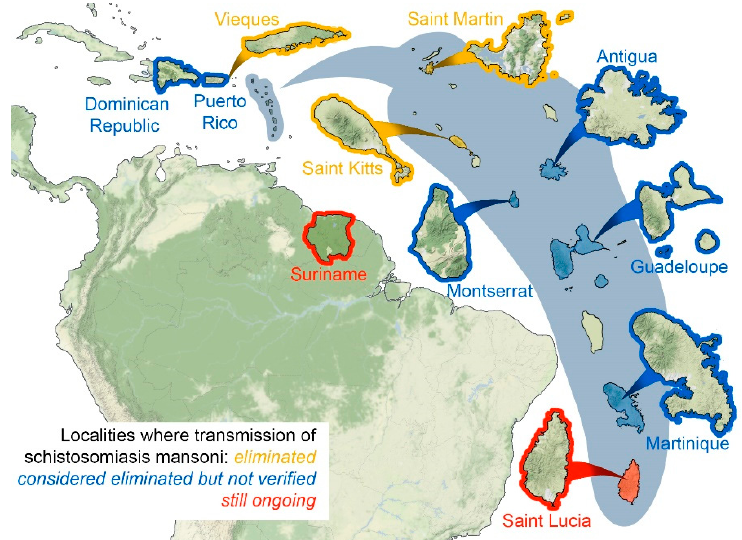
Figure 1. Map of the Caribbean region indicating localities with a history of schistosomiasis mansoni endemicity and their current transmission status.